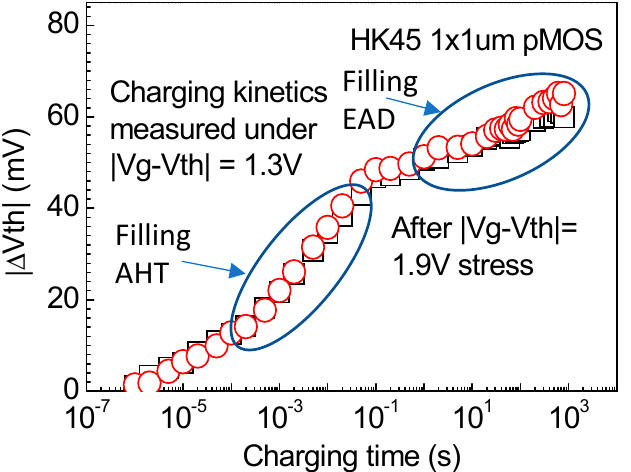
Figure 13. Recyclability of trapping–detrapping for as-grown defects. The symbol “ □ ” represents first filling. After discharging, the traps were refilled (the symbols “o”). The trapping was dominated by filling as-grown hole traps (AHTs) initially, followed by filling the energy-alternating defects (EADs) [53].